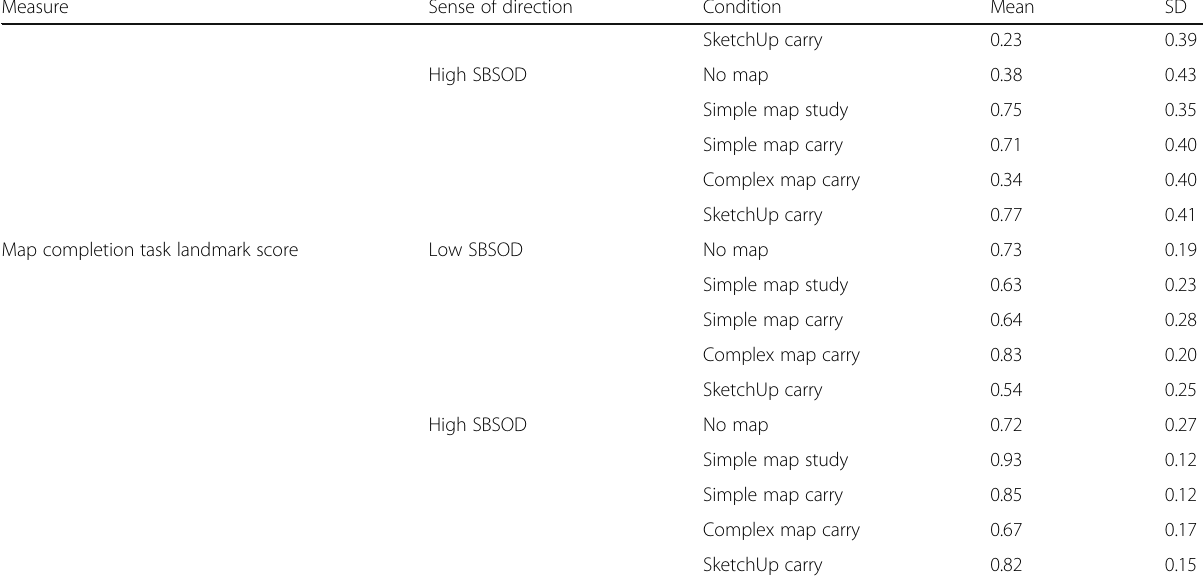
Table 4 Mean values and standard deviations (SDs) for each measure, split by map condition and sense of direction (Continued) Measure